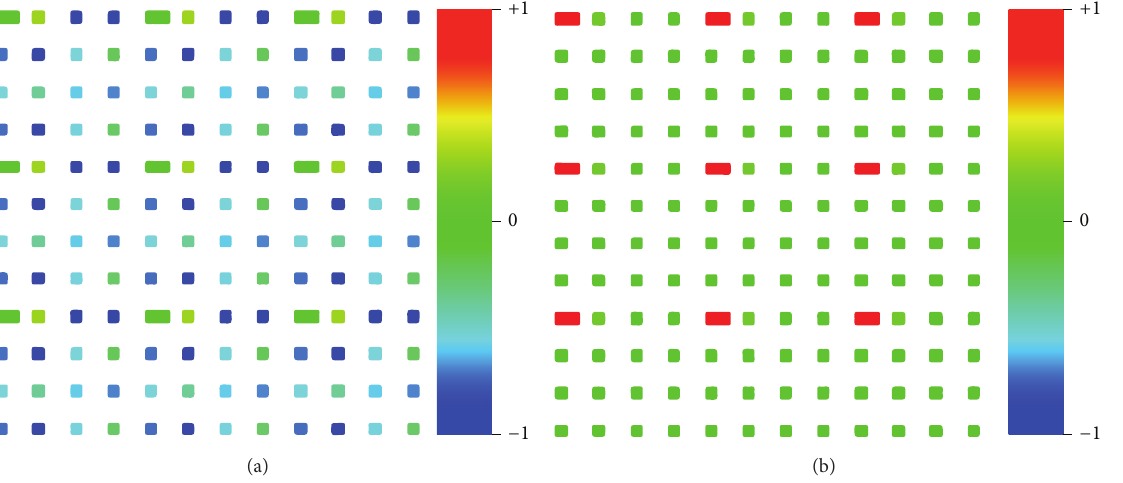
Figure 3: Out-of-plane real component of the dynamic magnetization (arbitrary units) for the two fundamental modes localized in complementary regions of the array (with B at 𝜃 = 0 ∘ ), consisting of the superposition of two sublattices with different lattice constant. Here, we plot an illustrative 3 × 3 periodic cell extract of the ideally infinite 2D array. (a) Fundamental spin wave mode ( 𝑘 1 = 0 ) localized within the elements of the primary sublattice only, showing an irregular intensity distribution discussed in the text; (b) fundamental spin wave mode ( 𝑘 2 = 0 ) strictly localized in the secondary sublattice.